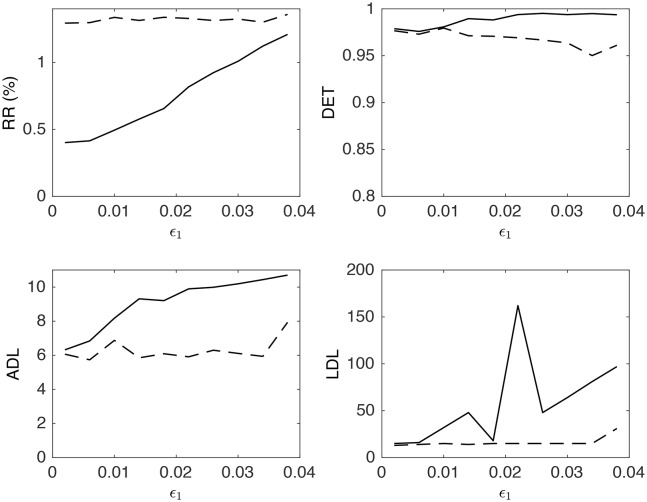
Recurrence measures RR, DET, ADL, and LDL for CRQA (dashed lines) and MdRQA (solid lines) as a function of the coupling constant ϵ1.